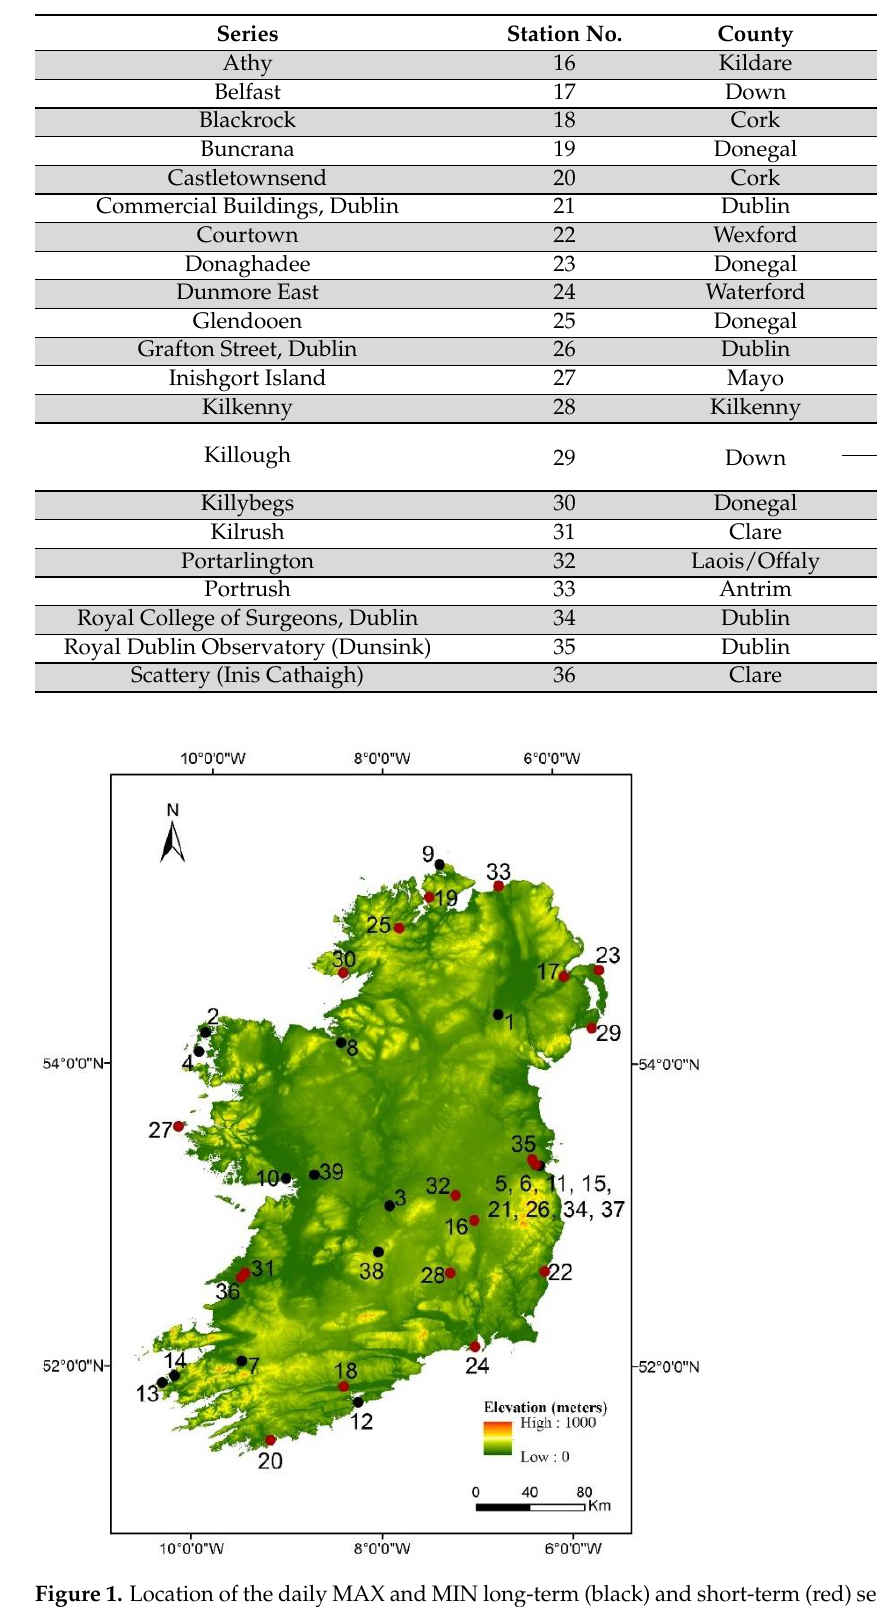
Table 2. Historical quality-controlled short-term daily MAX and MIN series.